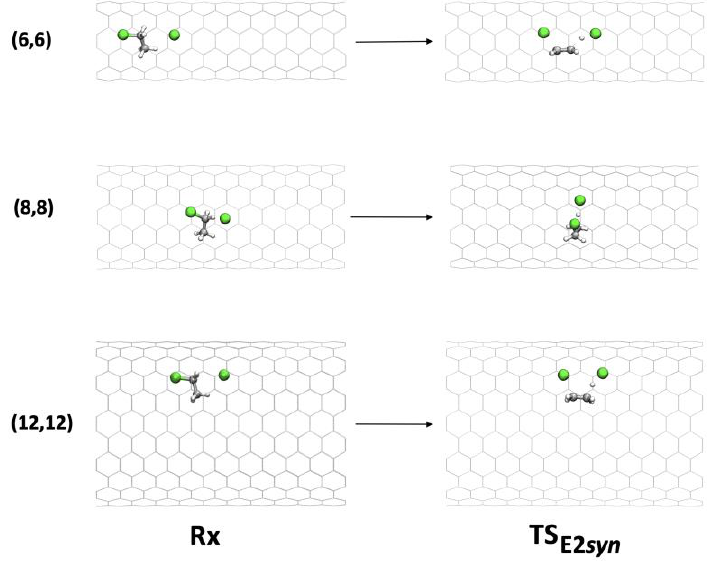
Figure 7. Geometries of Rx and TS in the syn -E2 mechanism inside (6,6), (8,8), and (12,12) CNTs. Inside CNT(6,6), in the TS, a distortion of the approach direction of the chlorine anion involved in deprotonation (C-H-Cl angles of 151° vs. 165° in the gas phase) was observed, with consequent destabilization. Inside CNT(7,7), CNT(8,8), and CNT(9,9), the chlorine anion was free enough to maintain its ideal angle of approach. The CNT walls fit well the TS structure, in particular in the case of CNT(8,8), in which the activation barrier was lowered by 8.3 kcal mol − 1 .